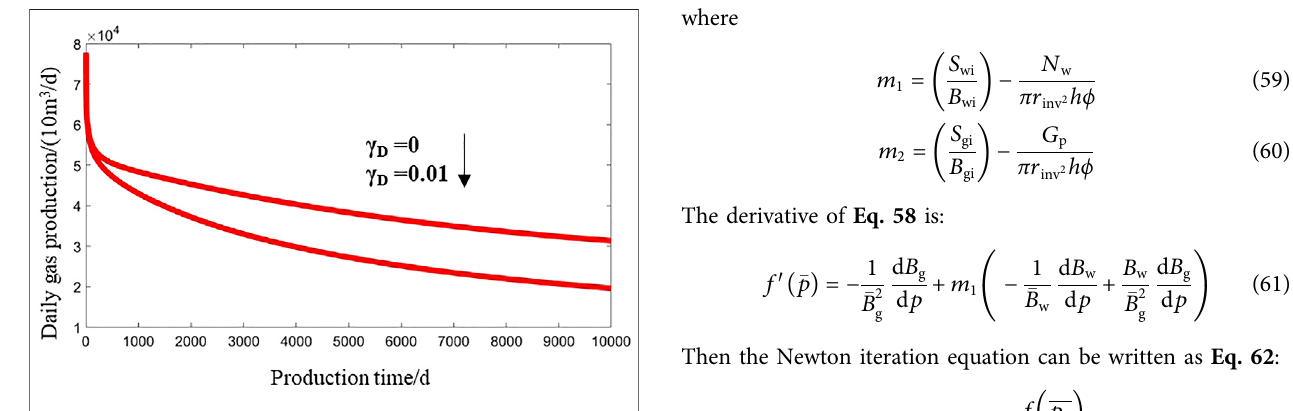
FIGURE5| Theeffectofstresssensitivityontheproductivityofgaswells with the two-phase fl ow of gas and water.